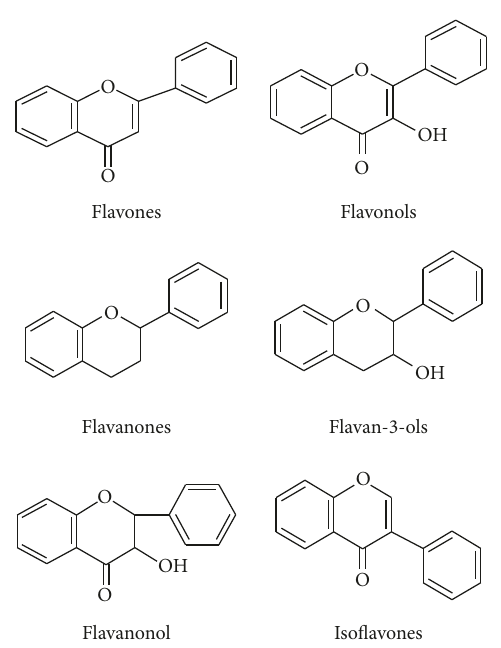
Figure 2: General classification and basic structure of